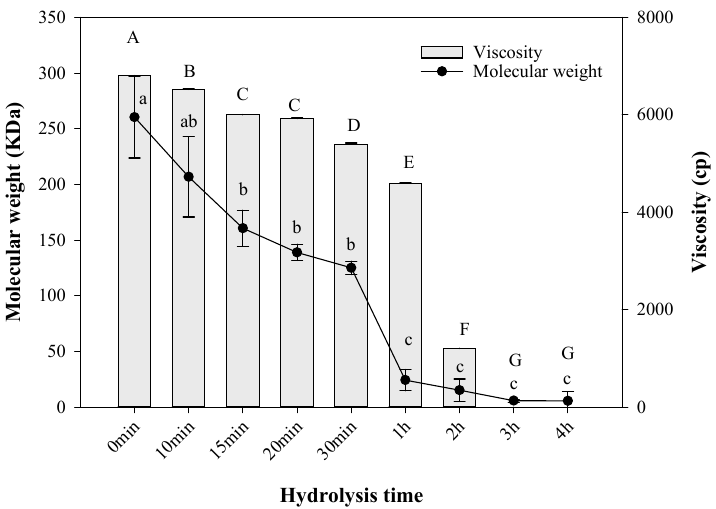
Figure 4. Co-relation between molecular weight and viscosity during the hydrolysis of ovine collagen. The different letters indicate significant difference at p ≤ 0.05.